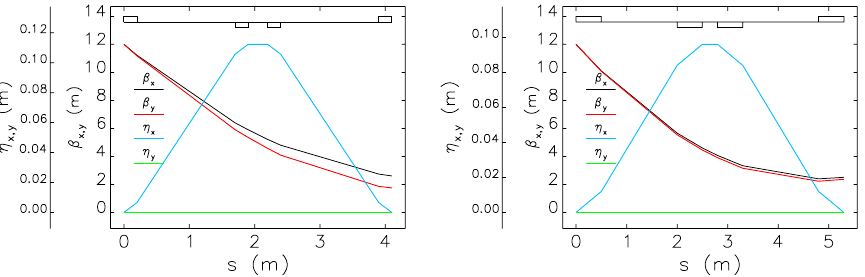
FIG. 3. Beta functions and dispersion functions in the bunch compressors. Left: bunch compressor one with a total length of 4 meters, where 0.2-meter-long dipole magnets are employed; right: bunch compressor two with a length of 5 meters, where 0.4-meter- long dipole magnets are employed. Black curve: horizontal beta function; red curve: vertical beta function; blue curve: horizontal dispersion function; green curve: horizontal angular dispersion function. The transverse optics is quite similar in these two bunch compressors, with the beta function decreasing from 12 to 2 meters in the bunch compressor, which is designed to minimize the CSR induced transverse emittance growth.